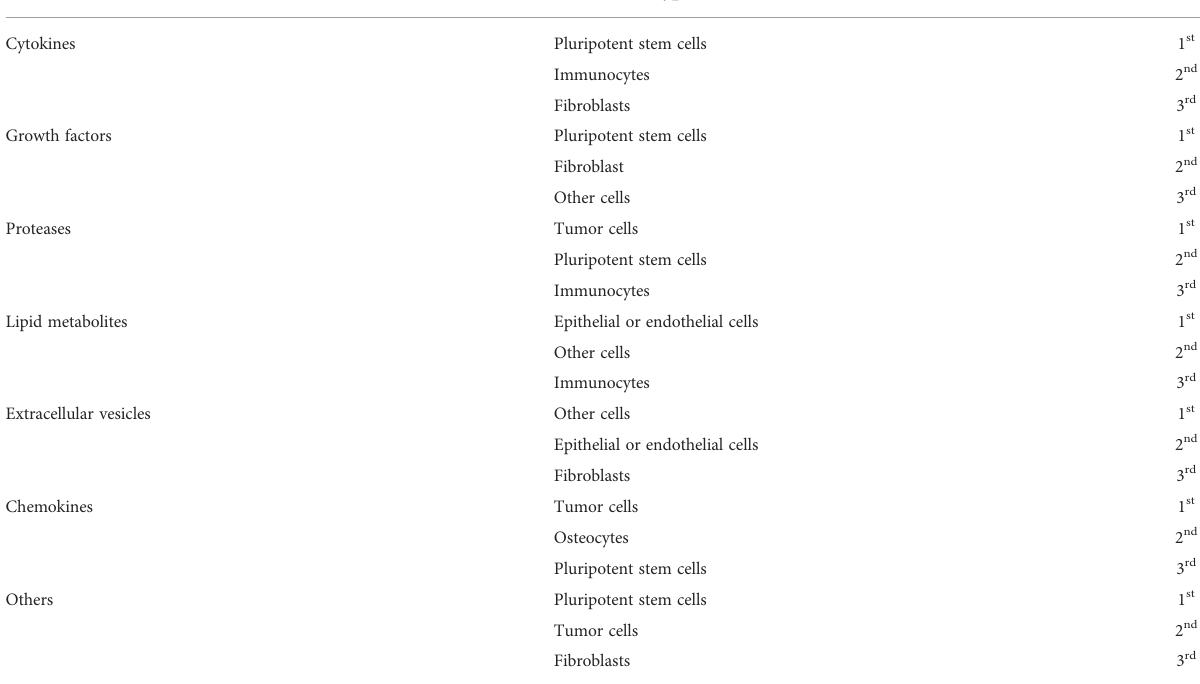
TABLE 1 Varies cell types where different SASP factors mainly act on. SASP